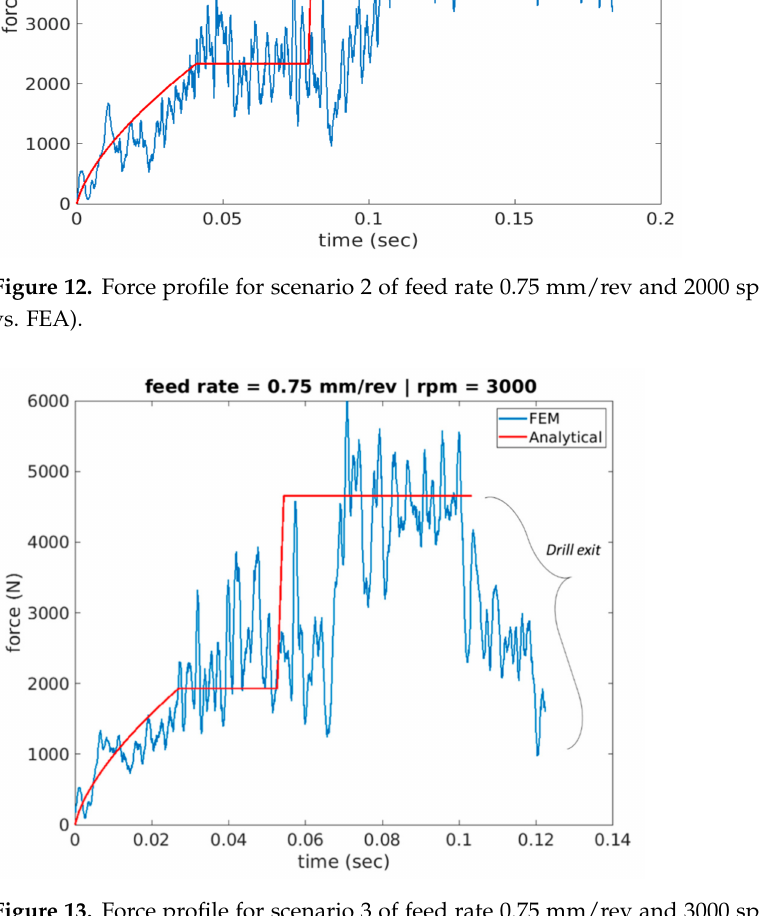
Figure 13. Force profile for scenario 3 of feed rate 0.75 mm/rev and 3000 spindle rpm (analytical vs.